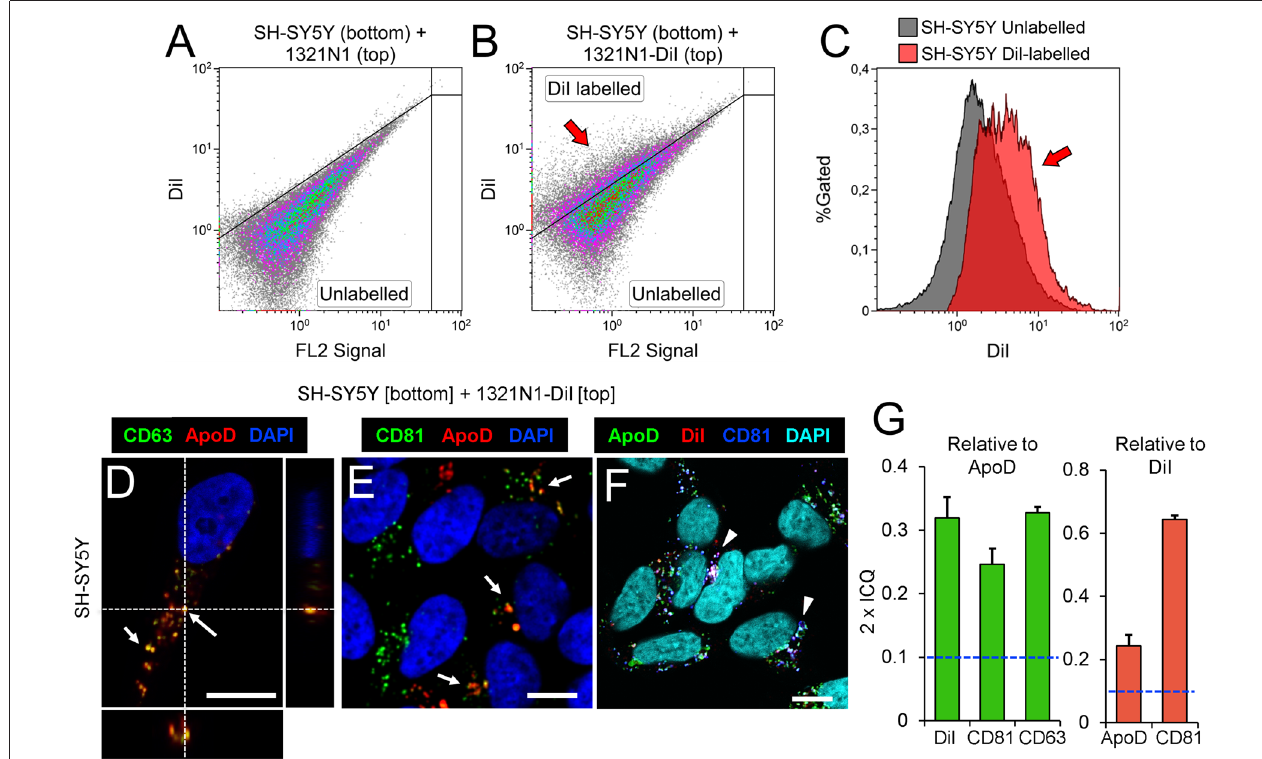
FIGURE 2 | Astrocyte-to-neuron communication is mediated by EVs that carry Apolipoprotein D (ApoD) into neurons. (A–C) Flow cytometry analyses of SH-SY5Y cells cultured with 1321N1 cells seeded in a Transwell inset. Astrocytic 1321N1 cells were either unlabeled (A) or labeled with DiI. (B,C) Dot plots show the existence of a population of DiI-positive SH-SY5Y neurons (arrow in B , representing 25.1%) when cultured with labeled 1321N1 astrocytes. The histogram in (C) displays the fluorescence increase in DiI-positive neurons (arrow), with median fluorescence increasing from 1.9 to 4.0 (a.u.). (D–F) Single plane confocal microscopy images extracted from Z-stacks obtained from unlabeled SH-SY5Y target cells cultured on the lower compartment of a Transwell assay while DiI-labeled 1321N1 donor cells were cultured on the insert. Immunofluorescence with ApoD, CD81 and CD63, and DiI signal are shown with different LUTs to properly display the colocalization of EV markers with ApoD (arrows in D,E ) or with DiI (arrowheads in F point to triple colocalization DiI-CD81-ApoD). Orthogonal views are shown in (D) to visualize the location of vesicular labeling within the cell. N = 20 confocal stacks/condition. Calibration bars: 5 µ m. (G) Average colocalization index (2 × ICQ) referenced either to ApoD signal (green bars) or to DiI signal (red bars) in SH-SY5Y neurons co-cultured in Transwell with DiI-labeled 1321N1 astrocytes. The dotted lines represents the colocalization threshold. Error bars represent SEM ( n = 20 cells/marker from four independent experiments).